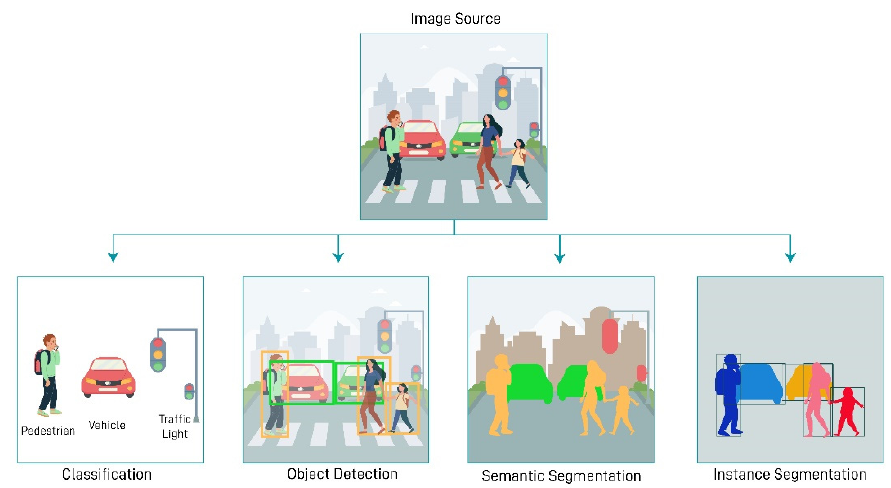
Figure 4. Basic Functions Performed by Computer Vision Techniques in the Field of ITS